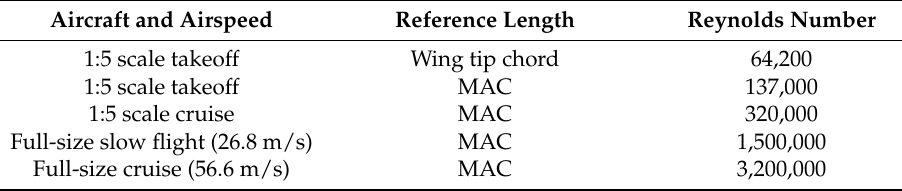
Table 1. Chord-based Reynolds numbers. MAC: mean aerodynamic